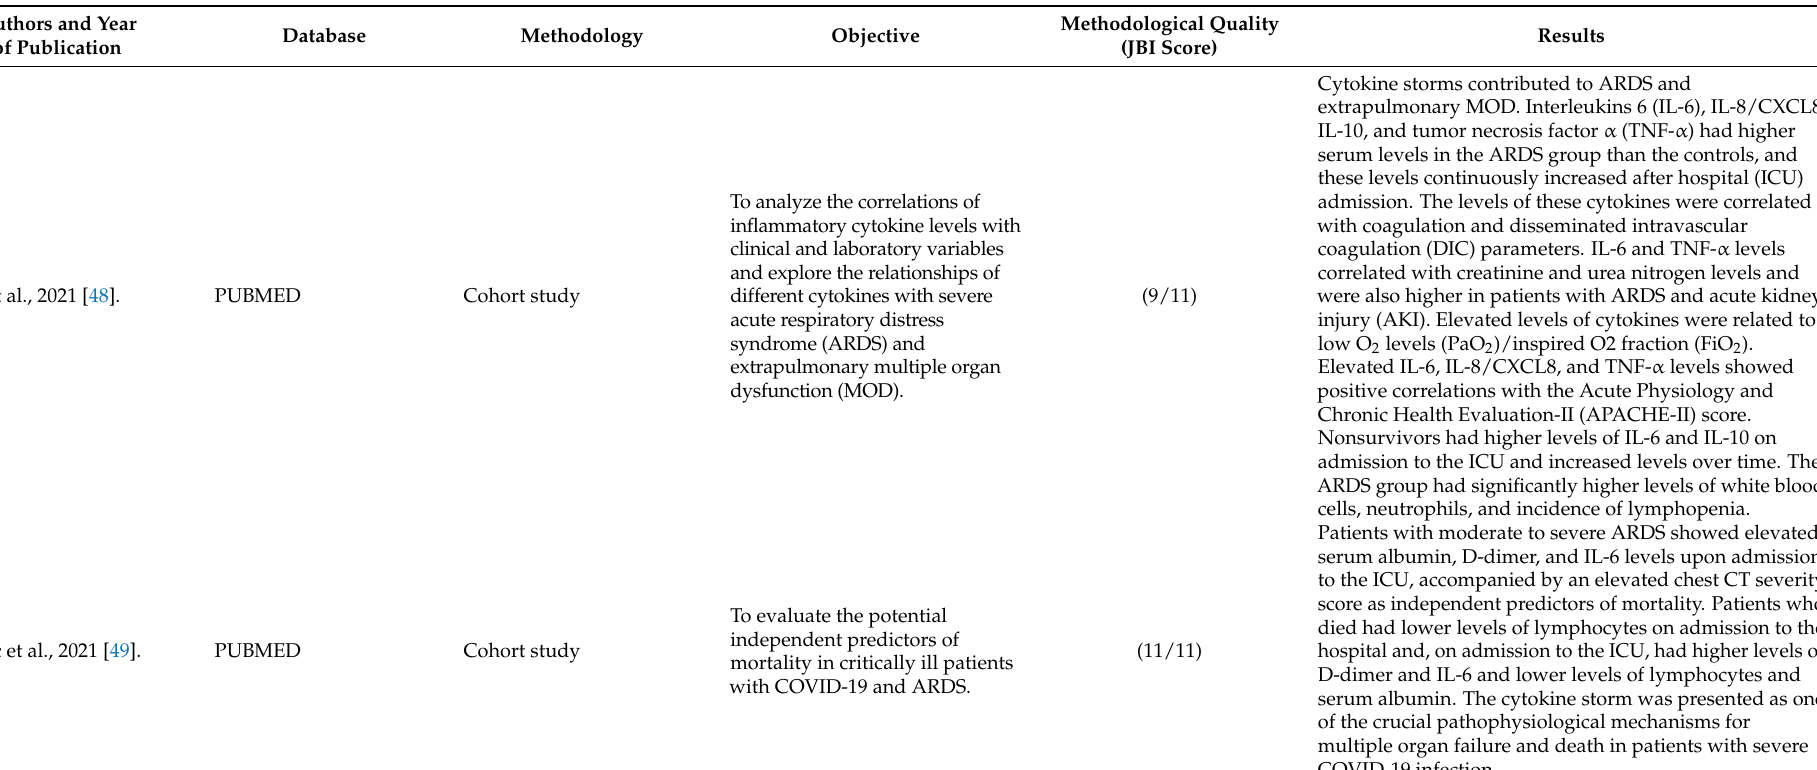
Table 1. Characteristics of the studies included in this systematic